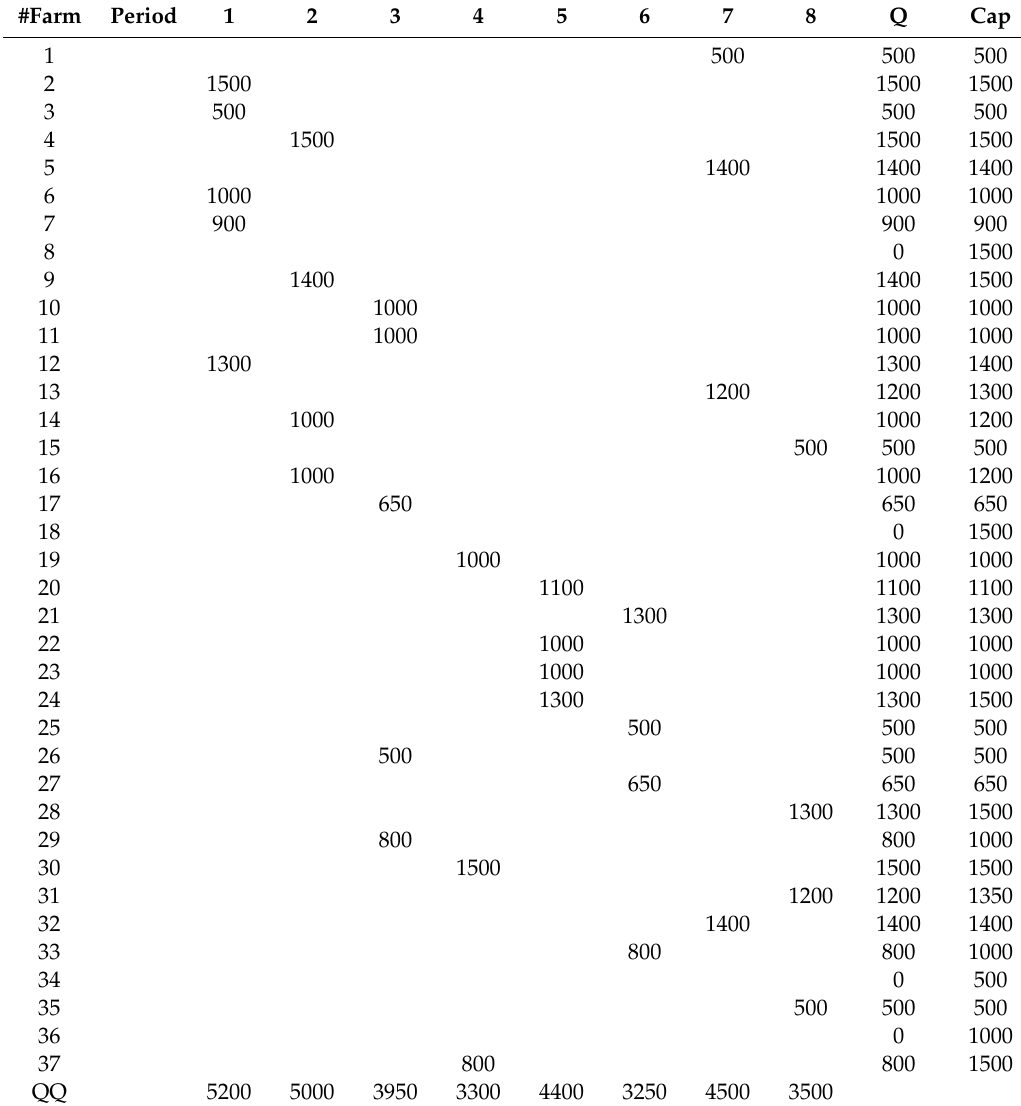
Table 14. Case study production